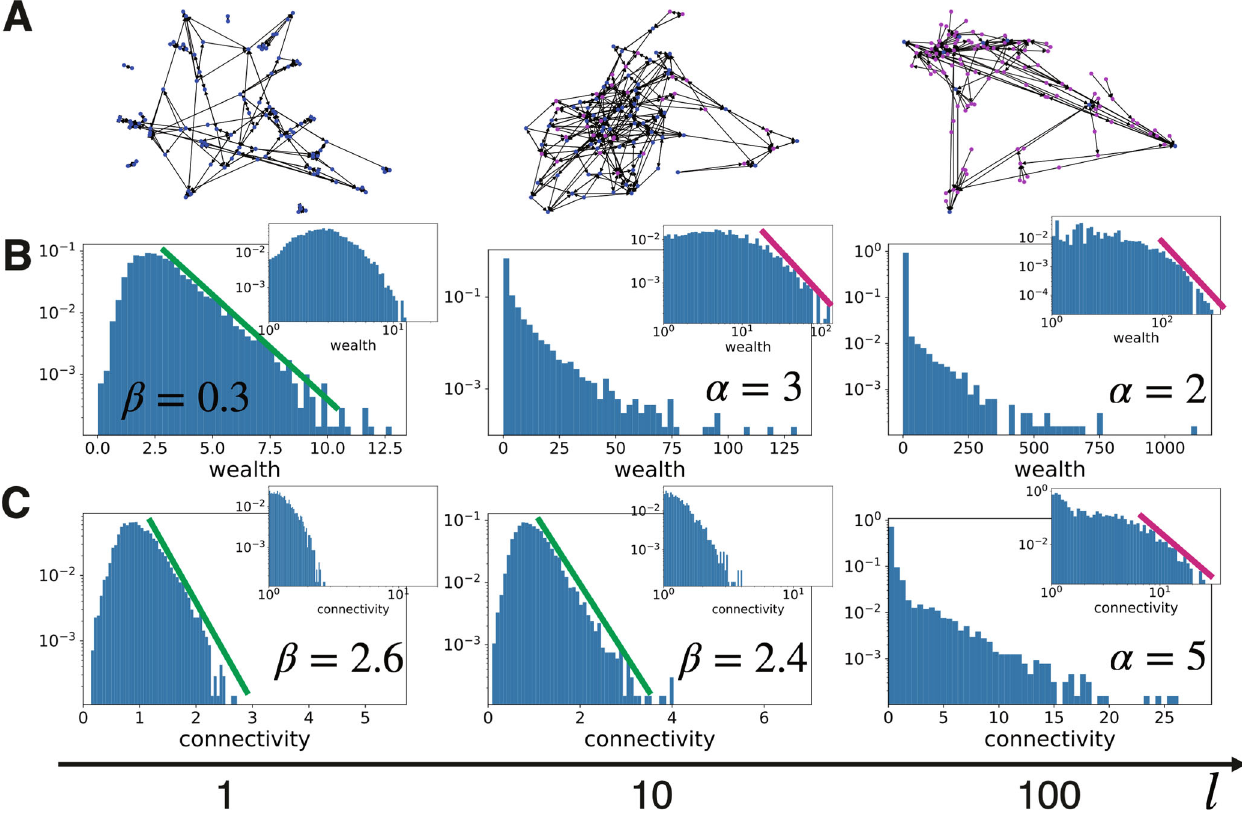
Fig. 2 Dependence of network structure, wealth distribution, and connectivity distribution on the frequency of the gift l . A Network structure in the fi nal state. Edges with weights larger than η are shown. Red nodes represent `repaying' — those who are in the repayment process. Blue nodes represent `free' — those who are not in that process. B The frequency distribution of wealth. C The frequency distribution of connectivity, that is, the sum of the weights of edges directed to each node. Insets are log – log plots of the frequency distributions. The green line is the exponential fi tting of the distribution exp ð(cid:2) β x Þ , whereas the pink lines are power-law fi tting x − α . The estimated values of α and β are shown in the fi gure. The fi gures show the typical result for each of the three `phases' described below. The coef fi cients of variation (SD/mean) of α and β values are below 0.2. Considering the small deviations, the presented examples are deemed to represent the results for each l